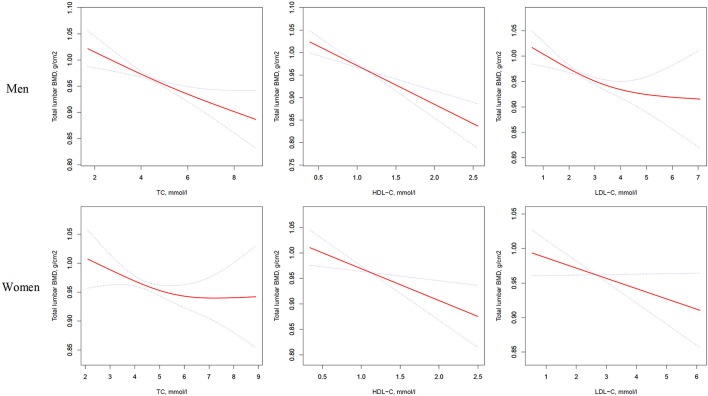
Multivariate adjusted smoothing spline plots of total lumbar BMD by TC, HDL-C, and LDL-C. Red dotted lines represent the spline plots of TC, HDL-C, and LDL-C and blue dotted lines represent the 95% CIs of the spline plots. Adjusted for age; diabetic duration(y); treatment of DM; smoking; drinking; BMI; cerebrovascular disease; kidney disease; family history of DM; diastolic blood pressure; FBG, unit; Cr, umol/l; BUN, mmol/l; Ca, unit; ALT, U/L; AST, U/L; ALP, U/L.